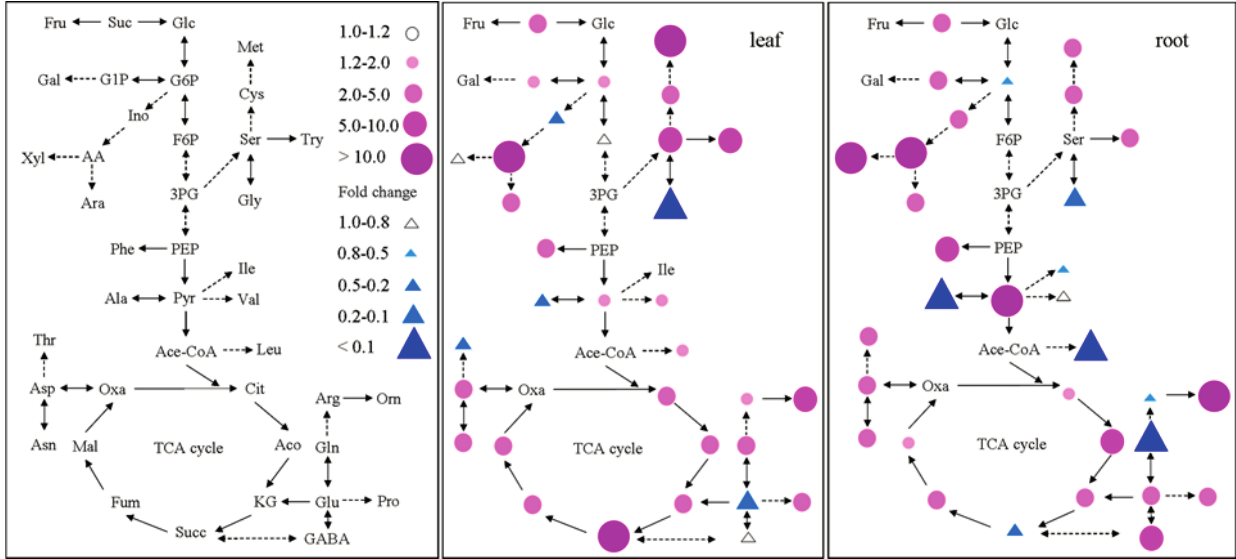
Figure 5. The fold change corresponds to the ratio of the concentration of individual metabolites involved in carbon and nitrogen metabolism in the GS2 -cosuppressed plants relative to the wild-type plants for the uppermost leaves and roots at the tillering stage under N condition. Red dots indicate increased metabolites, and blue triangles indicate decreased metabolites. Glc, glucose; Suc, sucrose; Fru, fructose; F6P, frutose-6-P; G6P, glucose-6-P; G1P, glucose-1-P; Gal, galactose; Ino, inositol; AA, ascorbic acid; Ara, arabinose; Xyl, xylitol; 3PG, 3-P-glycerate; PEP, phosphoenolpyruvate; Pyr, pyruvate; Ace-CoA, acetyl-CoA; Cit, citrate; Aco, aconitase; KG, ketoglutarate; Succ, succinate;